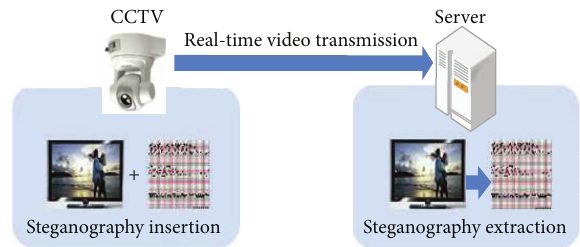
Figure 2: Overall structural diagram.